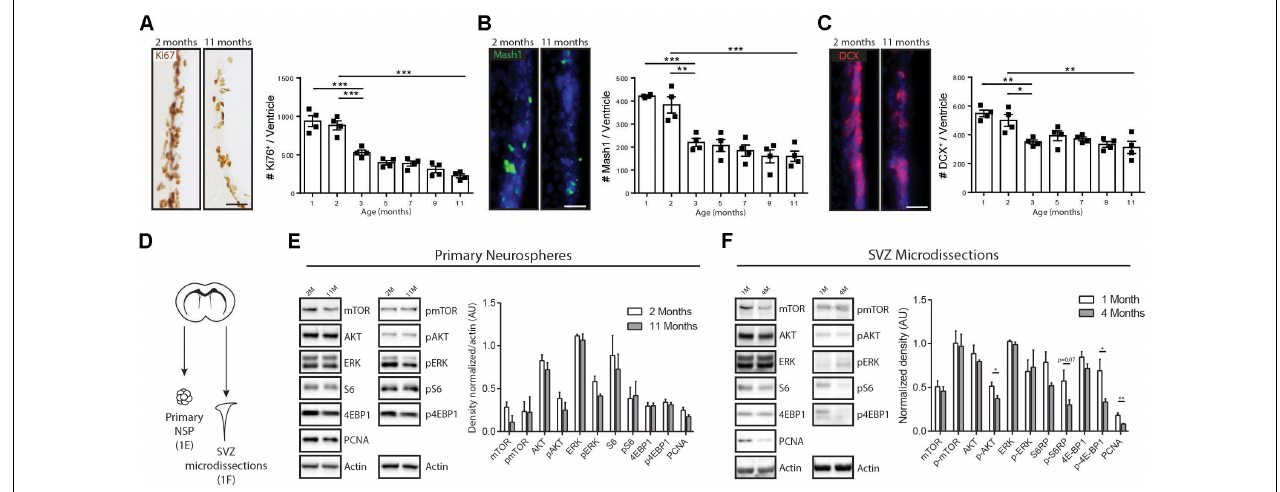
FIGURE 1 | Age-related modulations of neurogenesis and receptor tyrosine kinase-induced signaling pathways. (A–C) Kinetics of declining V-SVZ neurogenesis during early- and mid- adulthood. Time course analysis of (A) proliferating cells (Ki67 + cells), (B) TAPs (Mash1 + cells), and (C) Neuroblasts (DCX + cells), with representative pictures and quantifications for each. These cell populations decline sharply between 2 and 3 months of age and then more gradually until 11 months of age ( n = 4/group). One-way ANOVA with Tukey’s post hoc test. (D) Paradigm for Western blot analyses. (E) Western blots using lysates of primary neurospheres from the V-SVZ of 2- and 11-month-old mice (left) with densitometric quantification (right) ( n = 3/group). Unpaired t -tests. (F) Western blots using lysates of microdissected V-SVZ from 1- and 4-month-old mice (left) with densitometric quantification (right) ( n = 4/group). Unpaired t -tests. Scale bar represents 50 µ m in (A–C) . * p ≤ 0.05; ** p ≤ 0.01; *** p ≤